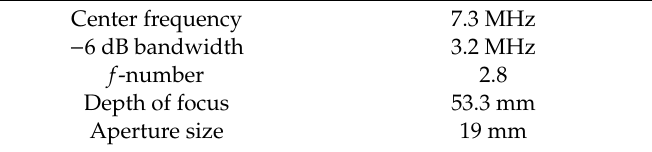
Figure 2. Pulse-echo response of the applied 7.5 MHz transducer. Table 1. Characteristics of the applied